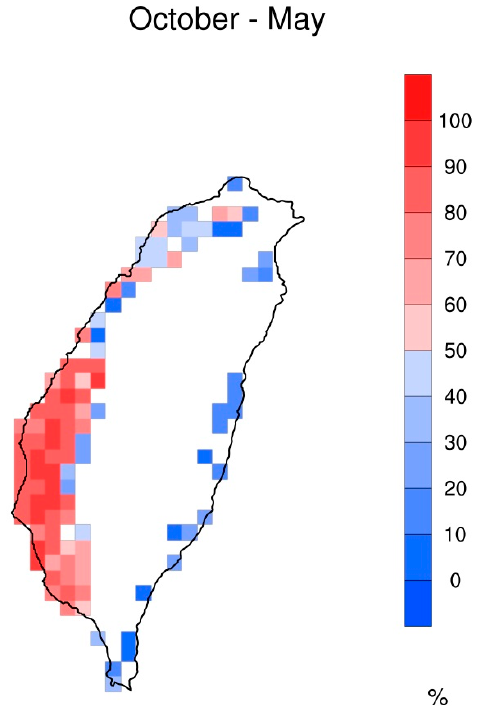
Figure 3. The spatial patterns of the severe drought occurrence from Figure 2.